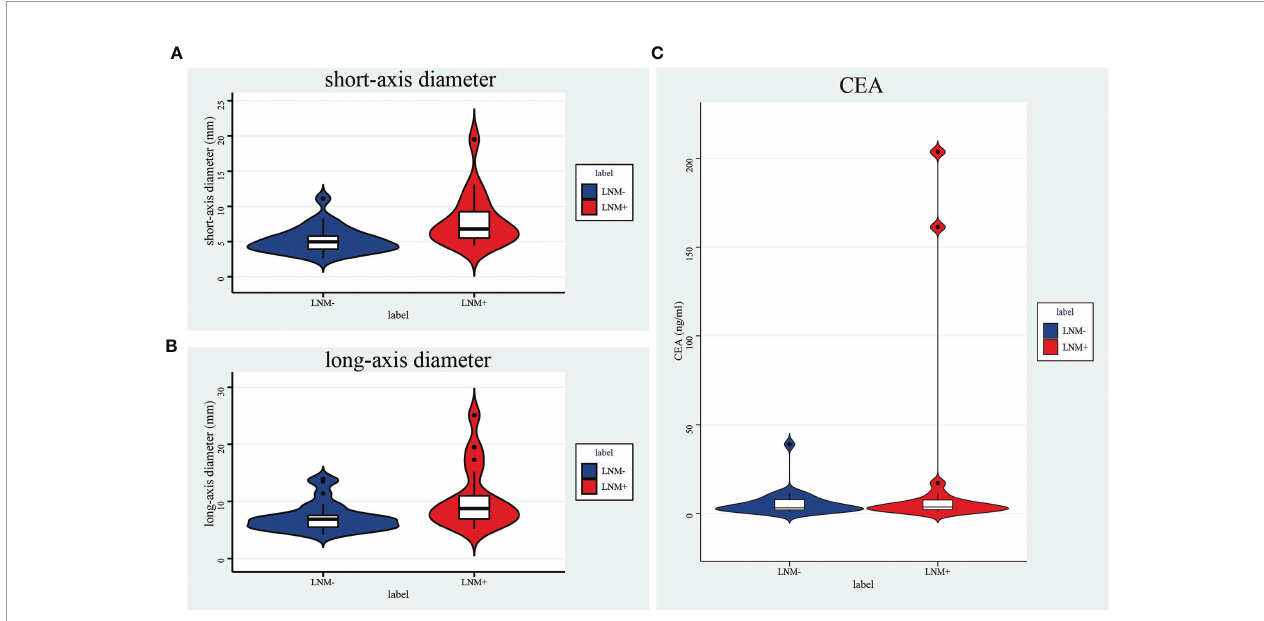
FIGURE 4 | Violin plot of a short-axis diameter (A) , a long-axis diameter (B) , and CEA (C) . All of them were signi fi cantly different between LNM+ and LNM-